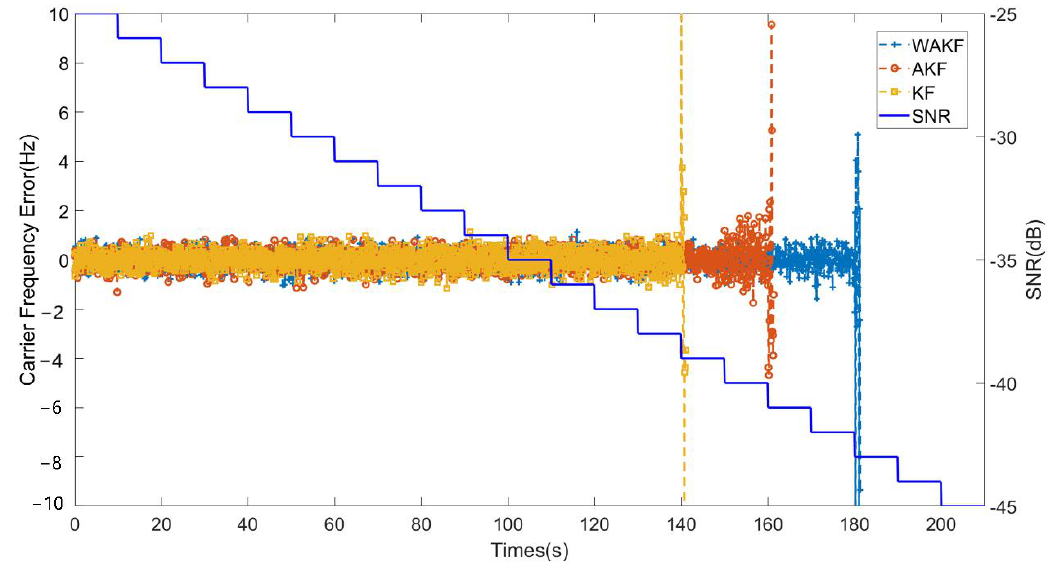
Figure 5. Tracking results under weak signal.